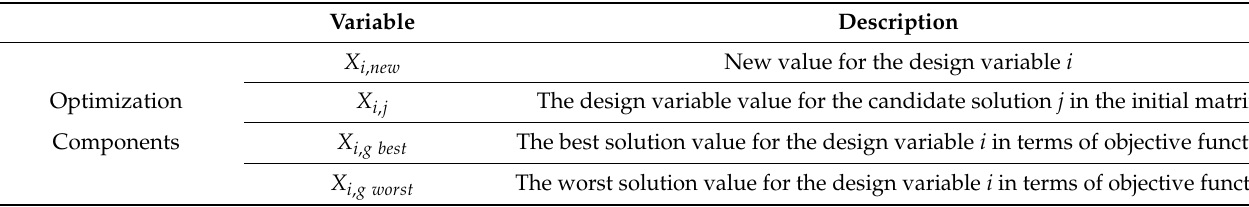
Table 1. JAYA optimization